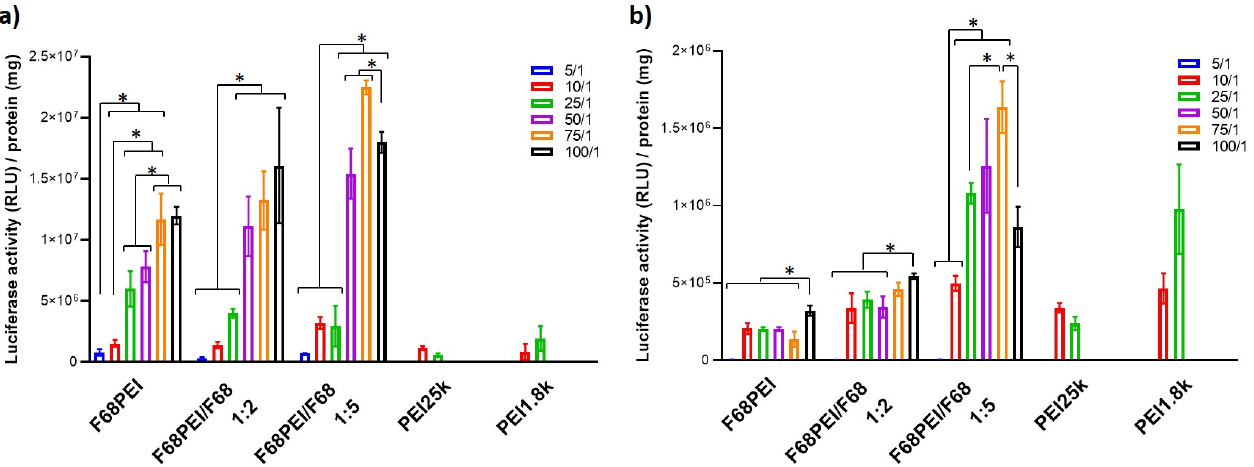
Figure 5. Transfection efficiency of F68PEI-based polyplexes in ( a ) SCC-9 and ( b ) U2OS cells. The following F68PEI formulations were tested: F68PEI, F68PEI/F68 1:2 and F68PEI/F68 1:5. Increasing